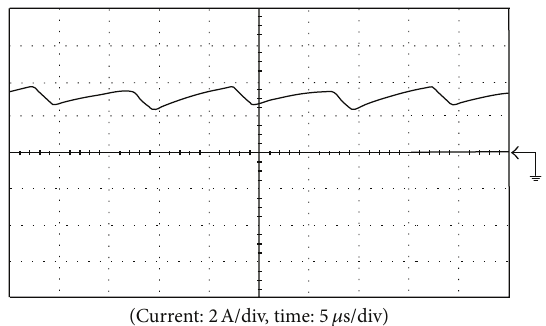
Figure 21: Simlated output inductor current while hybrid wind-PV power is 700 W.